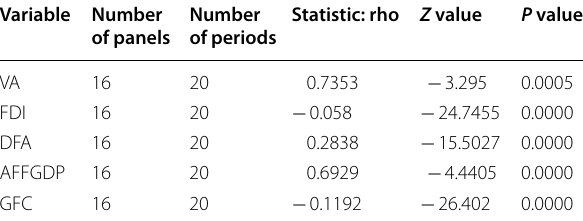
Table 2 Harris–Tzavalis unit root test